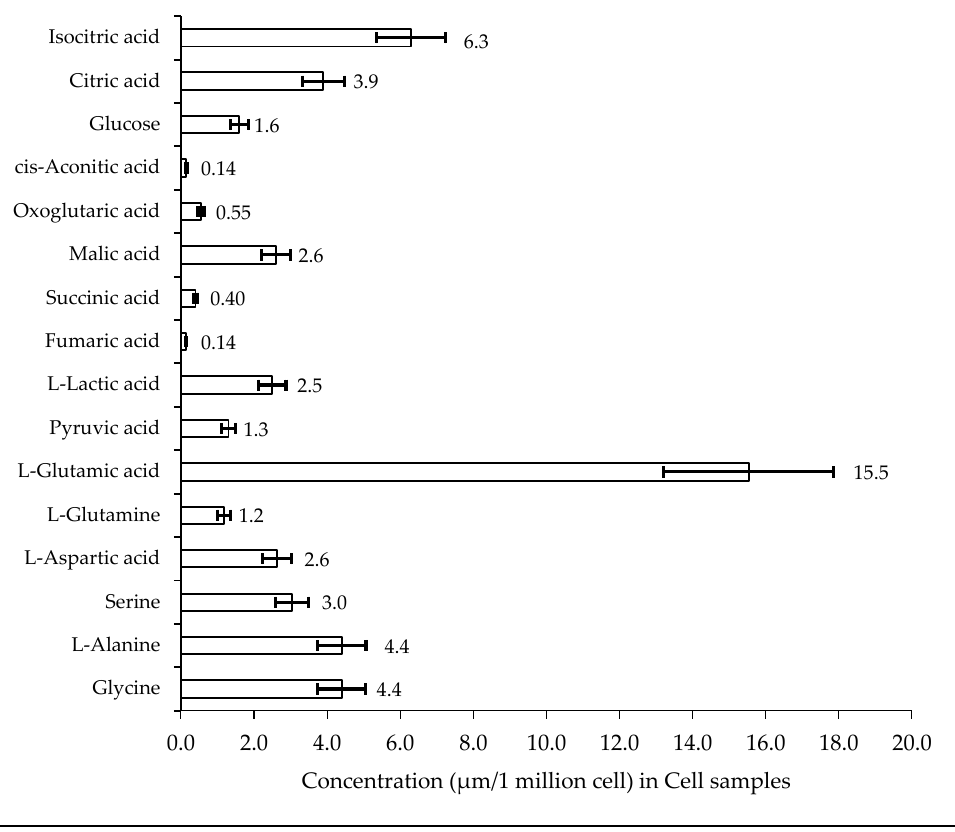
Figure 5. Measure of TCA cycle intermediate concentration in Kasumi-1 Cell line.